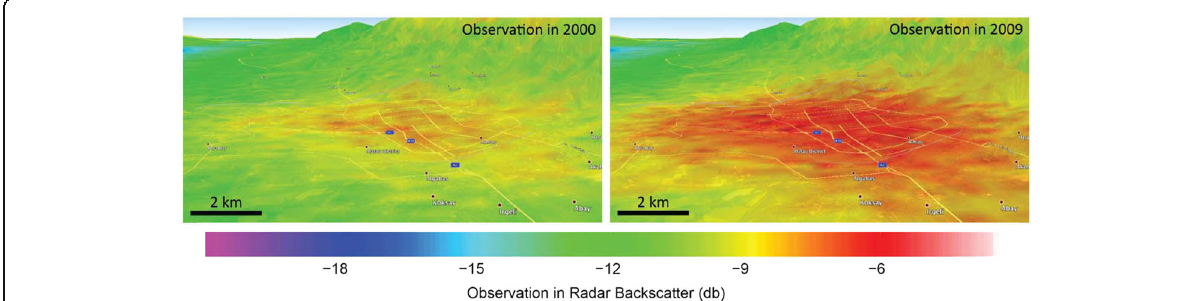
Fig. 16 Almaty urban region in Kazakhstan from DSM satellite observations in 2000 (left) and 2009 (right), translucently draped over 3D topography. Red represents main urban areas, transitioned into orange for urban area with less development, then to yellow for suburban, and finally to green for rural/natural/wilderness areas. Blue indicates surface water (lakes, reservoirs, etc.). Astounding expansion of the Almaty urban extent occurred between 2000 and 2009